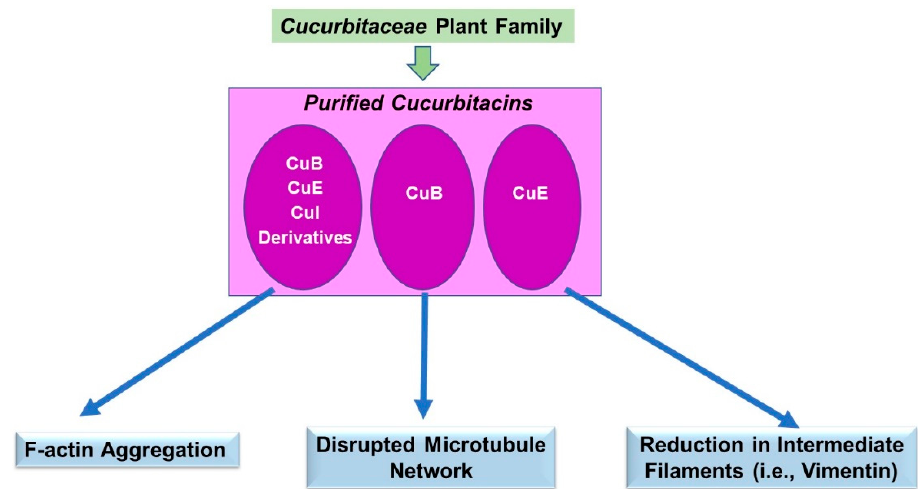
Figure 3. A schematic summary of the effects of metabolites from Cucurbitaceae on cytoskeletal alterations.